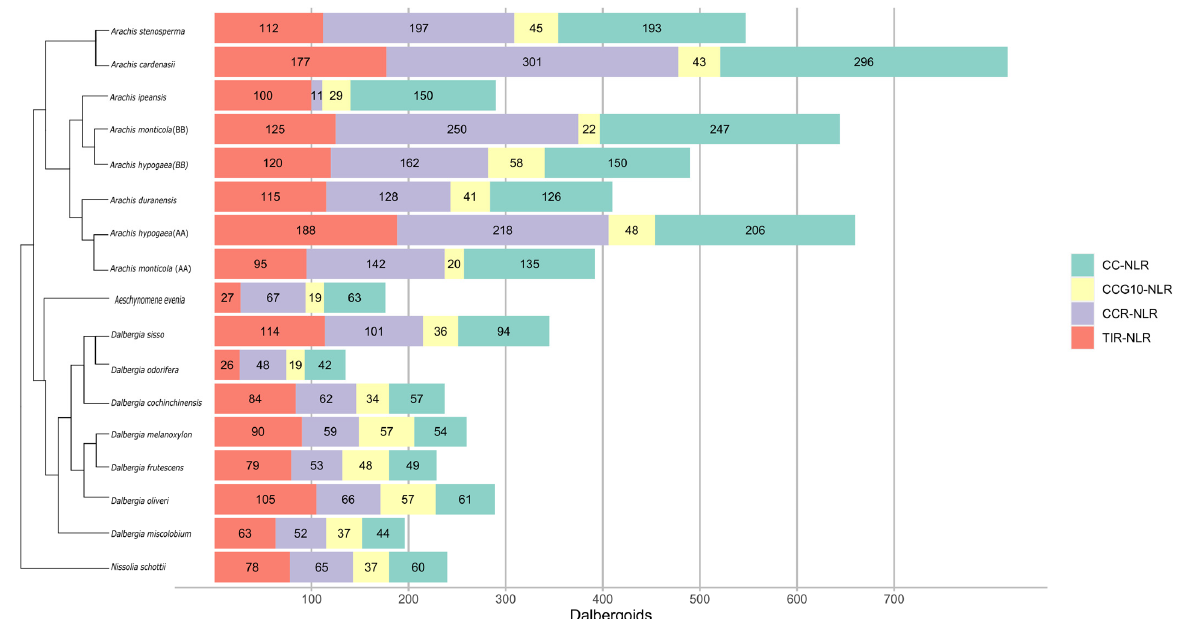
Figure 1. Horizontal bar plots illustrate the proper placement of four classes of NLRs genes indicated with different colors in different species of Adesmia , Dalbergia , and Pterocarpus clades.